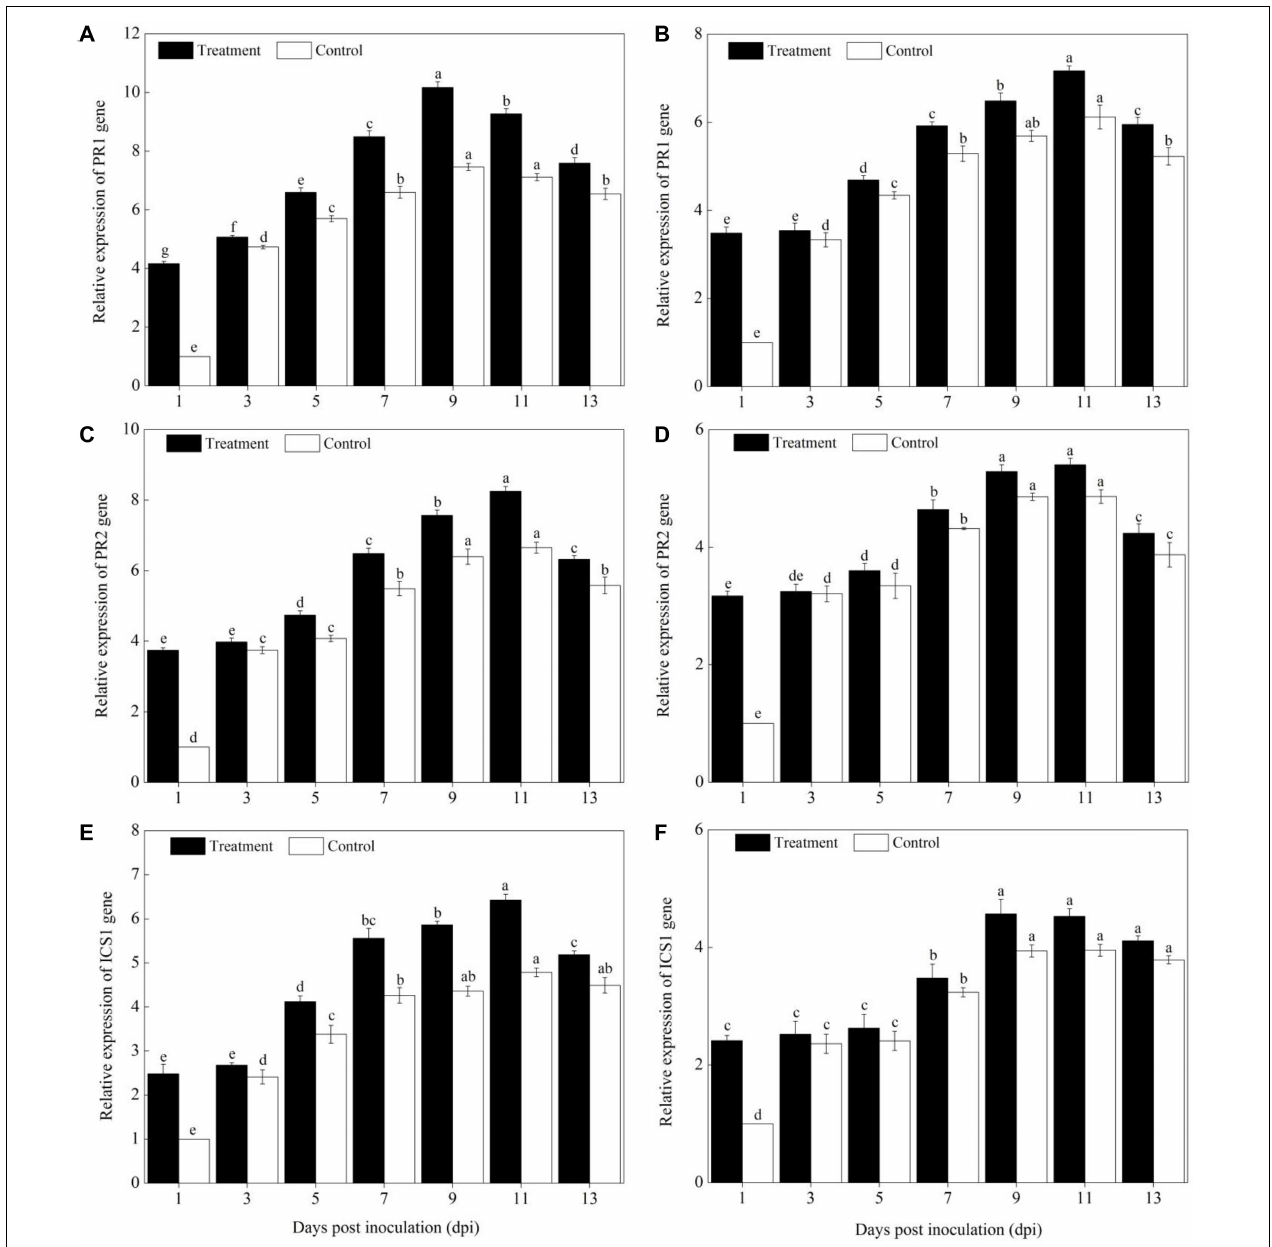
FIGURE 6 | Expression levels of SA signaling pathway marker genes in the leaves of Sixing F 1 and Jin 12 F 1 at different time points after being inoculated with Podosphaera xanthii. (A,C,E) The expression levels of PR1, PR2 , and ICS1 genes in Sixing F 1 , respectively; (B,D,F) the expression levels of PR1, PR2 , and ICS1 genes in Jin 12 F 1 , respectively. The line bars, different letters, and treatments are detailed in the footnote of Figure 2 and Table 2 .